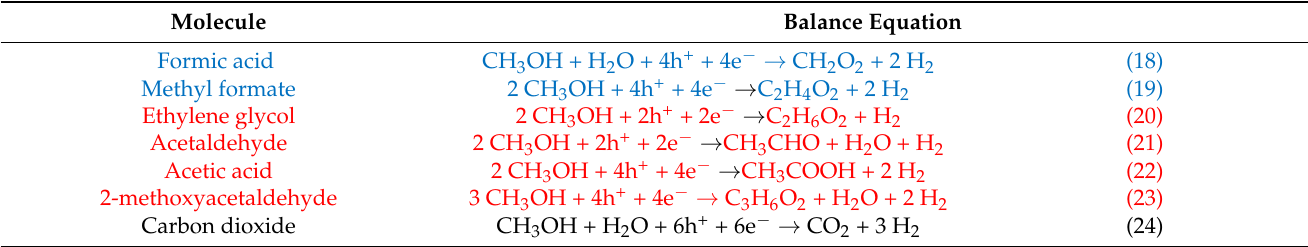
Table 1. Products generated in the reaction and corresponding balance equations. Products from alkoxy (in blue) and carbon-centered (in red) type radical species are presented in Equations (18)–(23), respectively. Carbon dioxide can be generated from all radical species. Equation number in